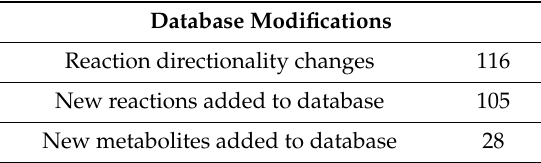
Table 4. Summary of extent of manual curation across the